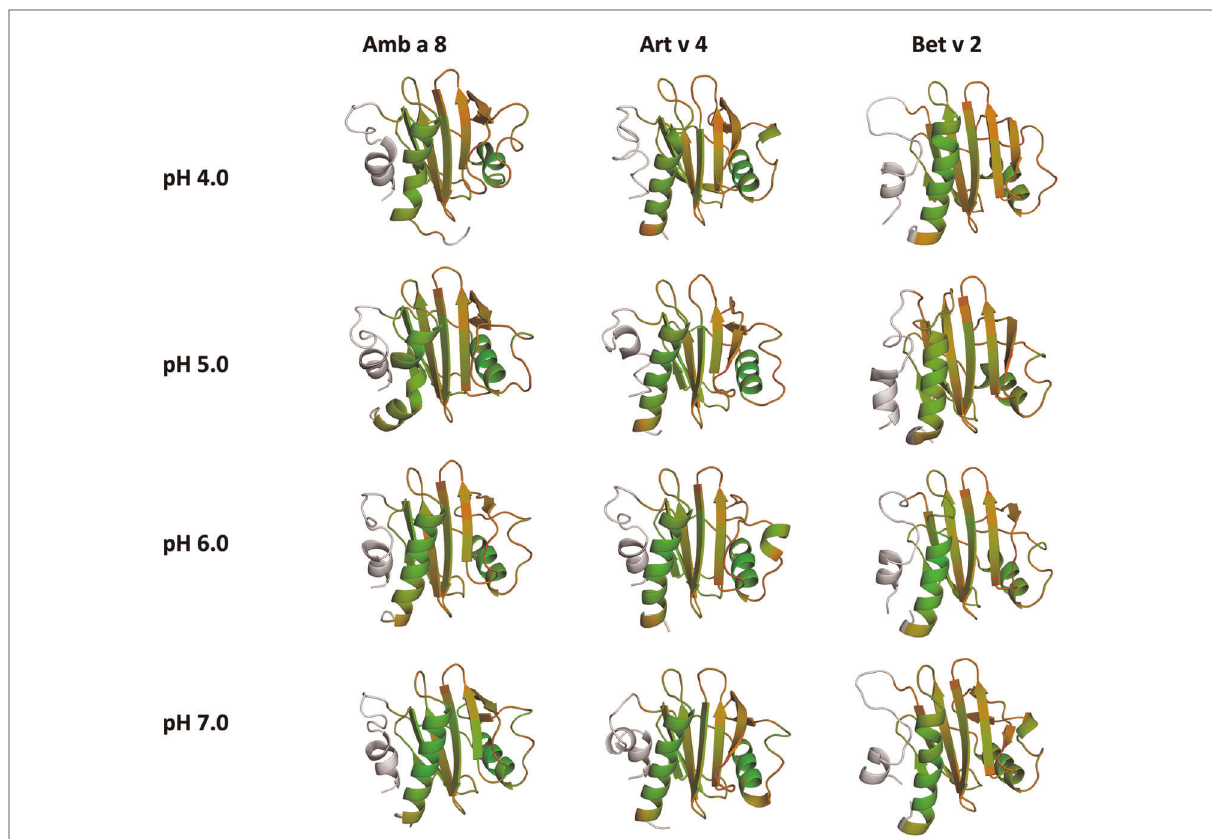
FIGURE 5 Quantifying the conformational diversity of each system. The overall sum of the residue-wise dihedral entropies at each pH value for all simulated systems is shown as a measure of structural heterogeneity. Higher values of S denote a higher fl exibility of the respective allergens. The structures are color-coded based on their entropy value: green (low fl exibility, red-high fl